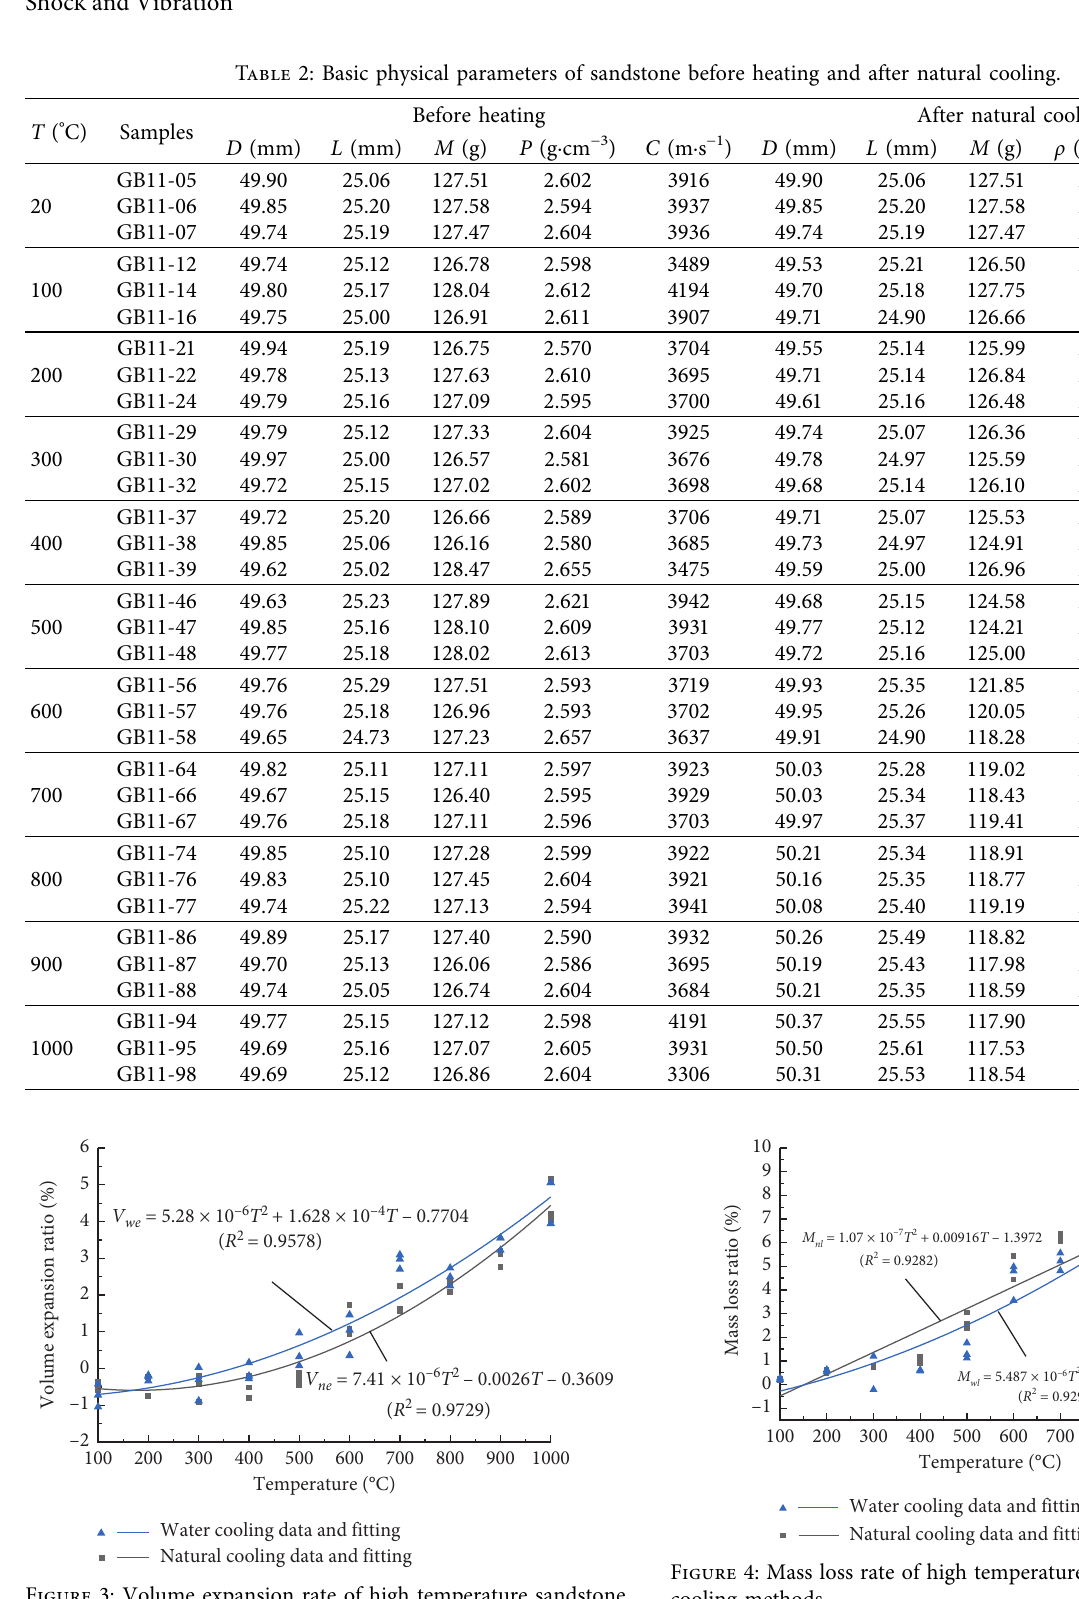
Figure 3: Volume expansion rate of high temperature sandstone after two cooling methods.